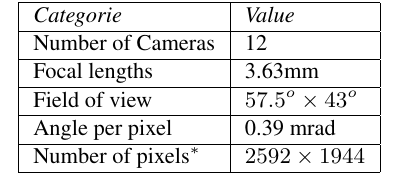
Table 1: Relevant data of the Trimble V10 (Trimble Navigation, 2016) angle per pixel to s = 3 . 63 mm tan(0 . 39 mrad ) = 1 . 4